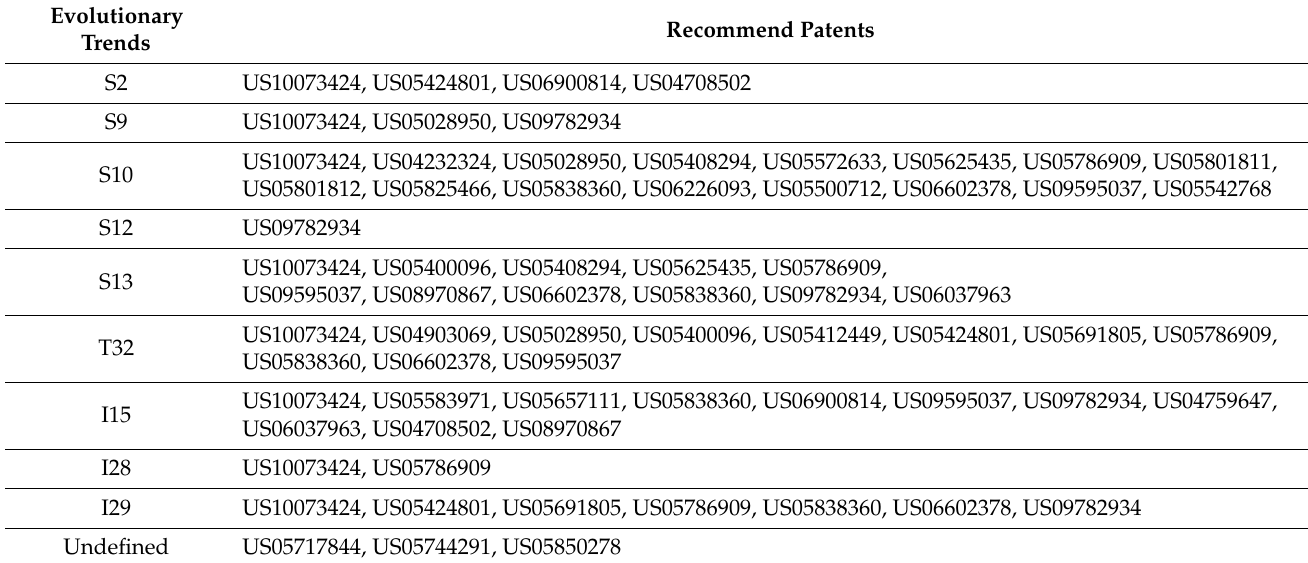
Table 5. Recommendations of the correlation between patents and evolutionary